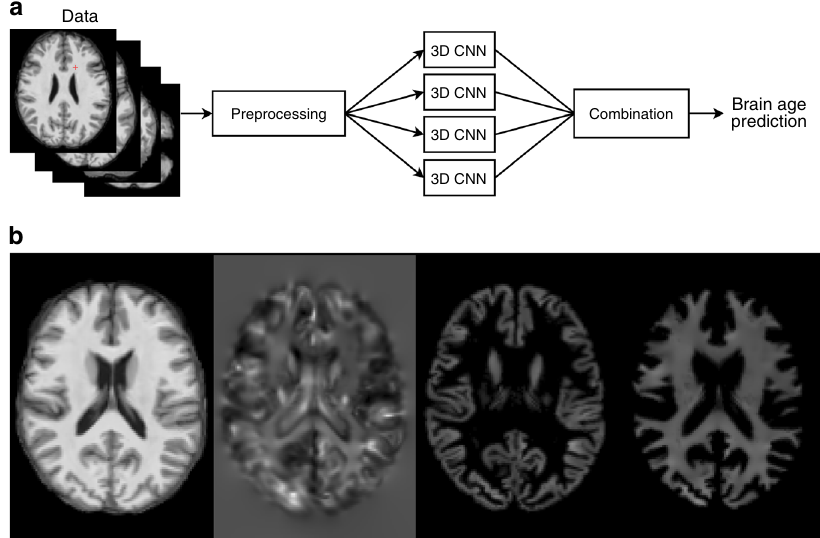
Fig. 1 Illustration of the proposed method and input data. a A fl owchart showing a high-level overview of the proposed brain age prediction system. b Examples of image types generated by the preprocessing step. From left to right: a registered T1-weighted slice, a Jacobian map slice, a GM segmented slice, and a WM segmented slice. Table 1 Chronological age prediction accuracy for the considered methods.